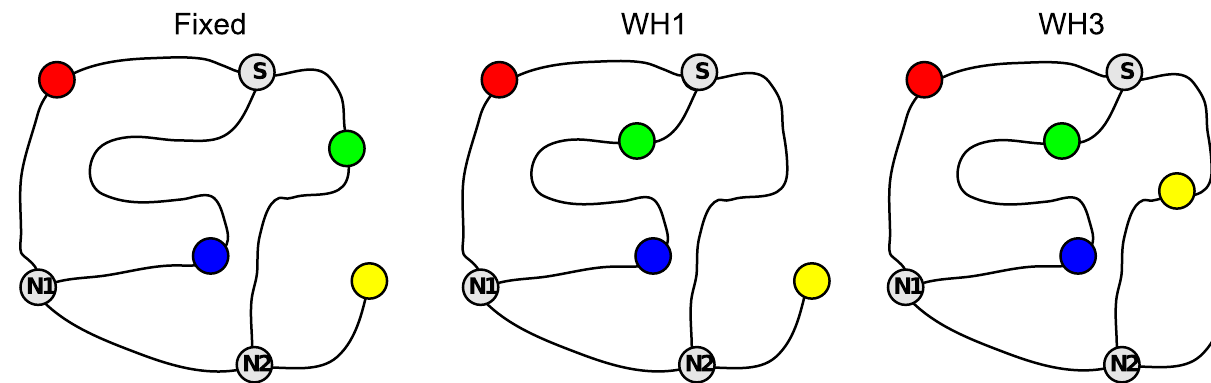
Fig 3. Topological graphs corresponding to the schematics shown in Fig 2A, 2B and 2C (Layout 1). Coloured circles represent targets; S, N1 and N2 are 3-way junctions; S is the start location.